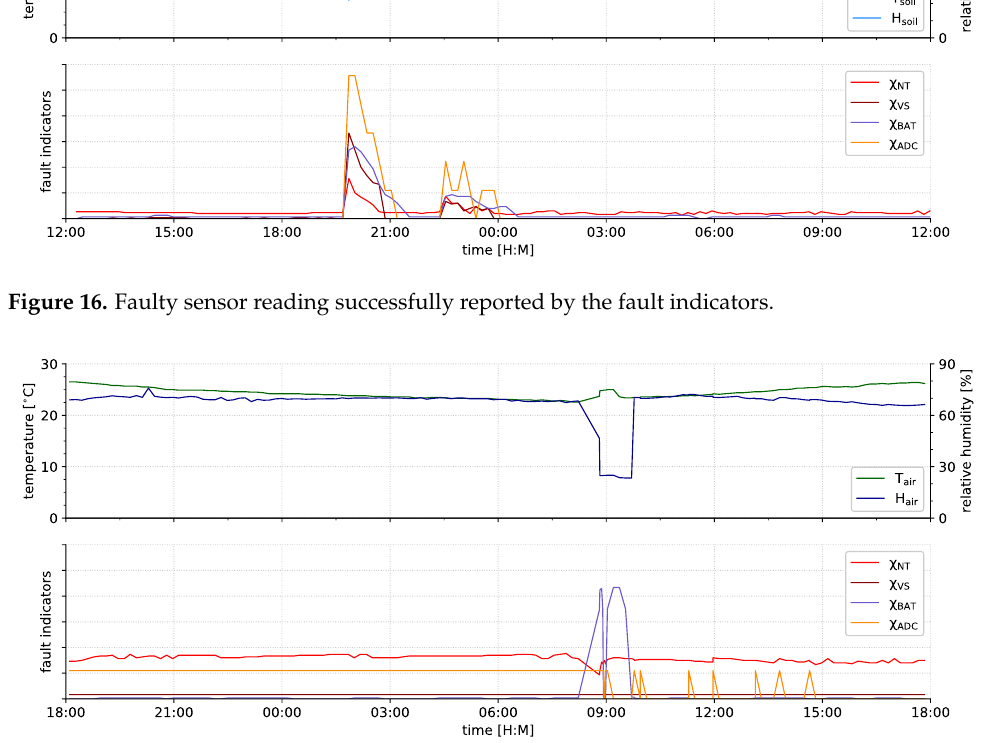
Figure 17. Fault-induced data anomaly highlighted by the fault